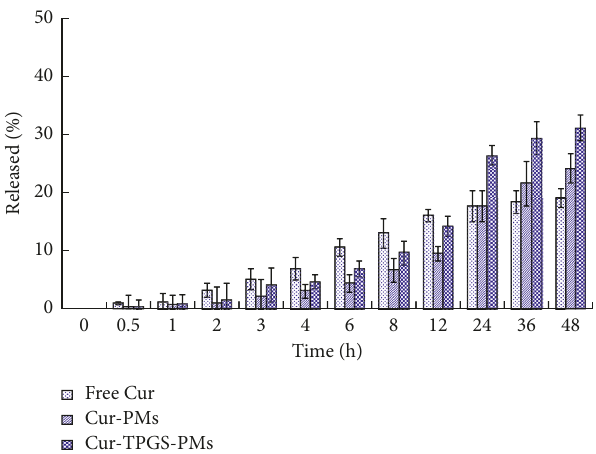
Figure 6: Curcumin release rates (%) of free Cur, Cur-PMs, and Cur-TPGS-PMs in pH 1.2 for 2 h and pH 7.4.